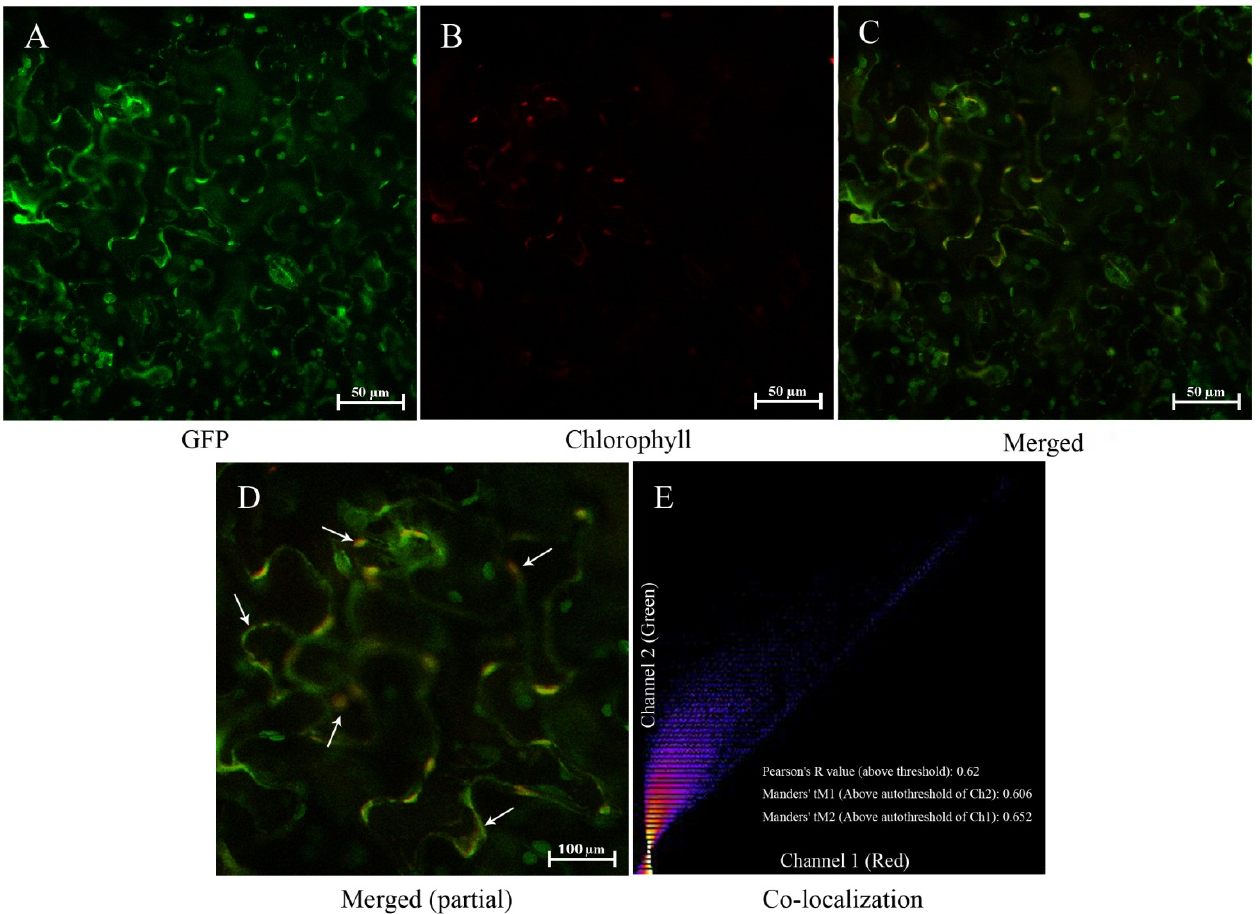
Figure 3. Subcellular localization of PoGPT1 (( A ), GFP; ( B ), Chlorophyll; ( C ), Merged; ( D ), Merged (partial); ( E ), Co-localization). Nicotiana benthamiana leaf lower epidermis cells were infected with the 35:: PoGPT1 -GFP construct mediated by Agrobacterium tumefaciens strain GV3101. Green fluorescence indicates the fusion protein location. Scale bar: 50 μ m, 100 μ m.